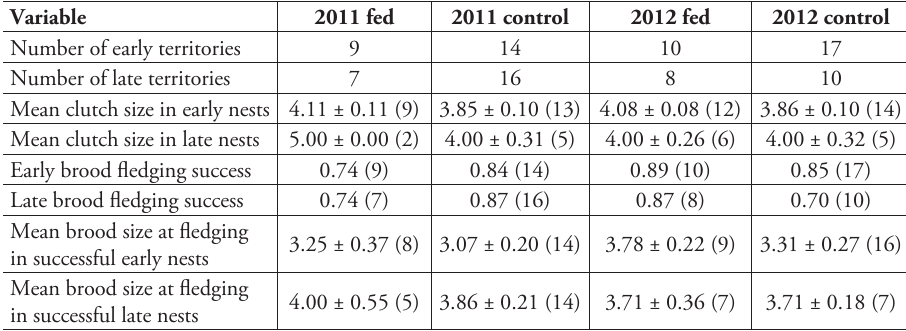
Table 1. Ring ouzel reproductive success parameters measured for early and late broods at all fed and control nests during 2011–12. Figures presented are means ± s.e., with sample size given in parentheses. Data for mean clutch size in late nests comes only from individually identifiable colour ringed